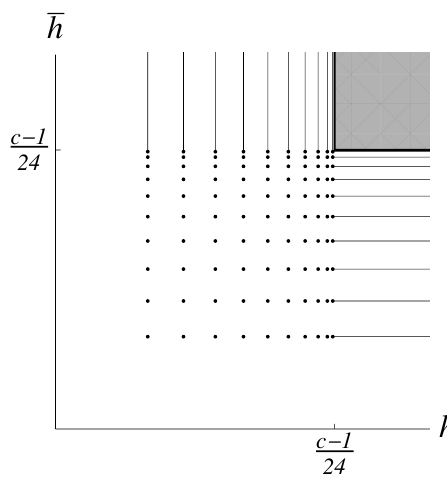
Figure 5 . The VMFT spectrum, combining holomorphic and anti-holomorphic